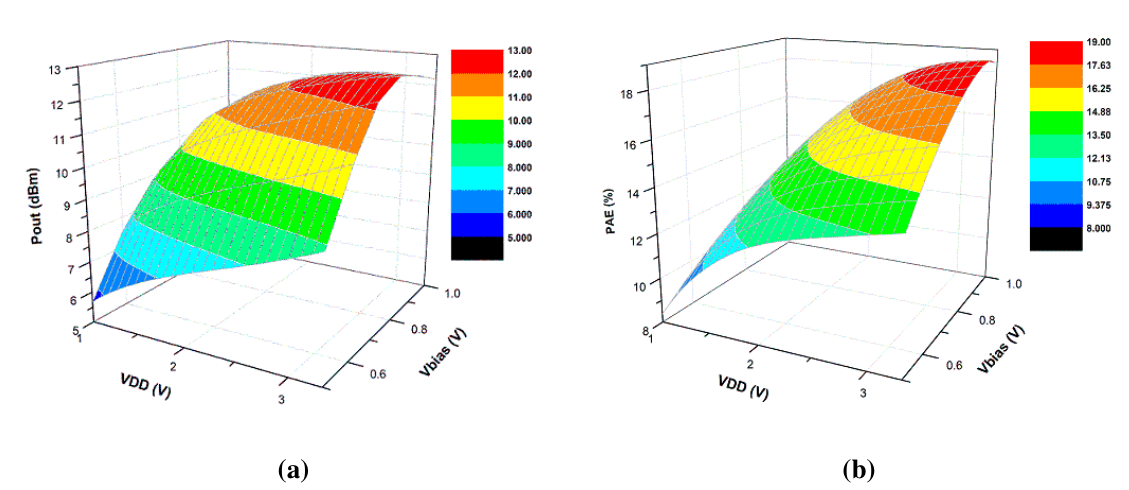
Figure 4. ( a ) Supply voltage and gate biasing versus output power; ( b ) supply voltage and gate biasing versus power-added efficiency.